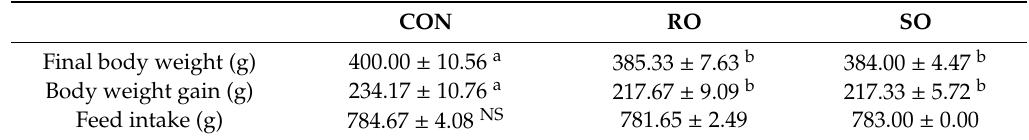
Table 2. Body weight and feed intake.